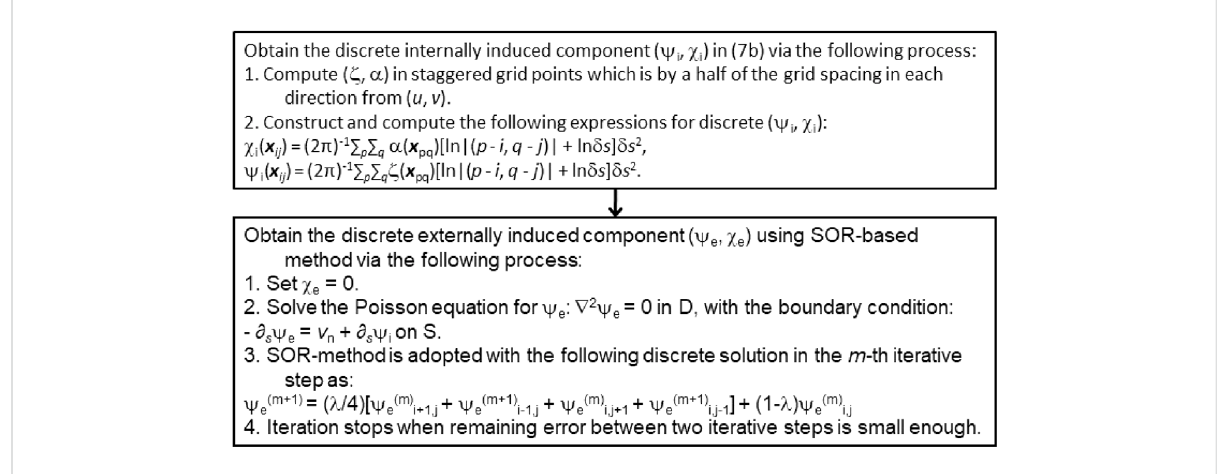
FIGURE 1 Computational procedure of the hybrid integral – SOR method (Modi fi ed from Figure 1 in Cao et al.,